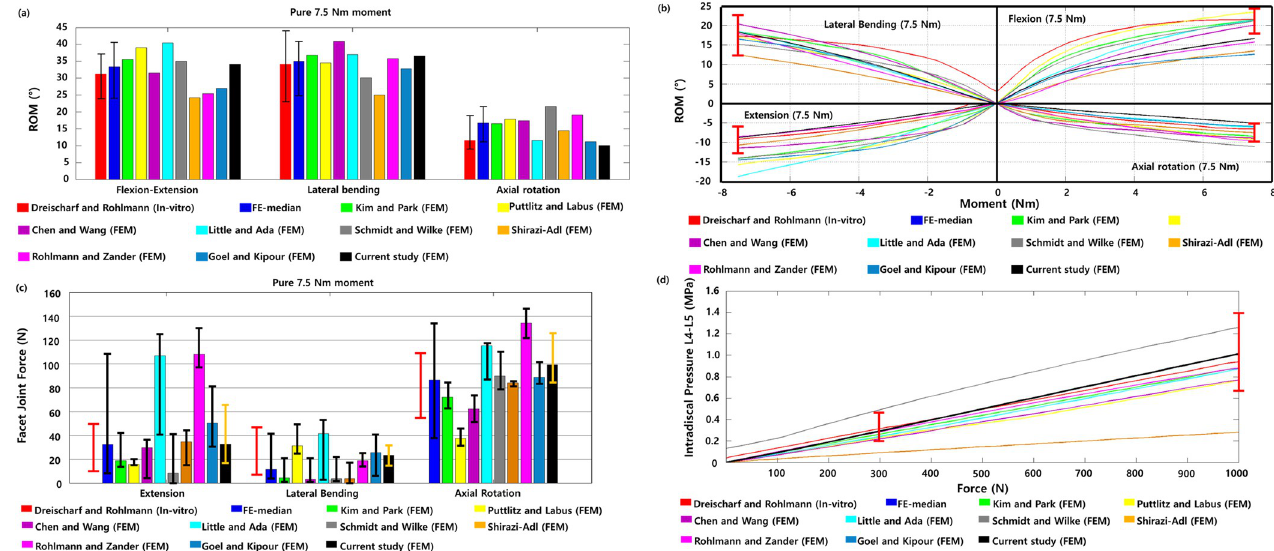
Fig 3. (a) Range of motion (ROM) of the healthy lumbar spine from entire L1 to L5 segments (i.e., healthy L1-L5 lumbar spine) under pure 7.5 N � m moment (The red bar is the median value of previous in vitro experimental findings, and other bars represent previous and current findings of finite element analyses). (b) ROM of the healthy L1-L5 under pure moment of 0 to 7.5 N � m (The red range bar represents previous findings of in vitro experiments under 7.5 N � m moment). (c) Facet joint forces (FJFs) of the healthy L1-L5 under pure 7.5 N � m moment (The red bar is the median value of previous in vitro experimental findings, and other bars represent previous and current findings of finite element analyses). (d) Nucleus pulposus pressure of the L4-L5 intervertebral disc under follower load of 0 to 1000 N (The red range bar represents previous findings of in vitro experiments under 300 N and 1000 N follower